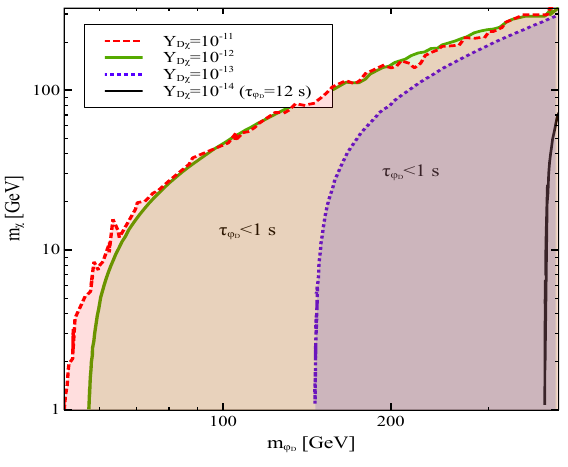
plane for fixed values of the coupling Y D